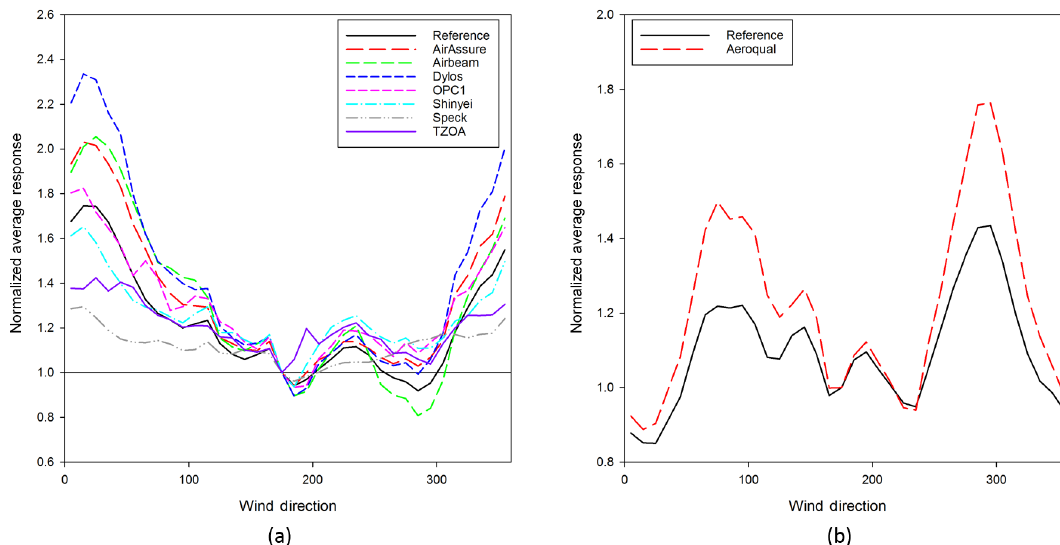
Figure 5. Wind direction patterns for (a) PM 2 . 5 and (b) O 3 sensor and reference measurements.